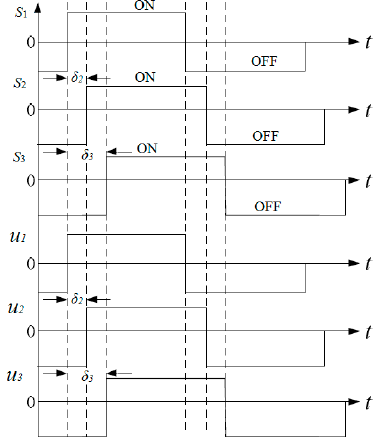
Figure 3. Topology of the TAB converter.